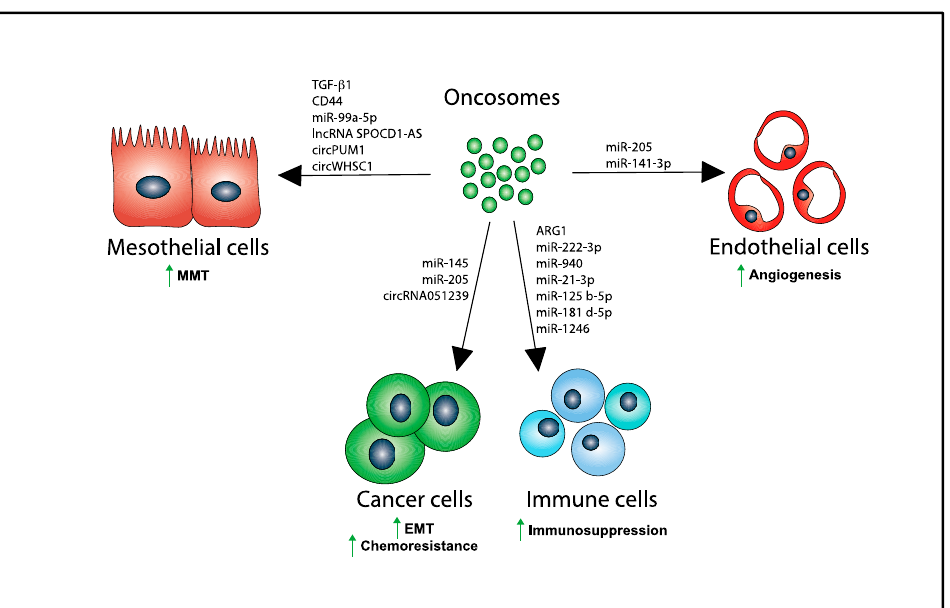
Figure 2. Several biomolecules are transferred via oncosomes from producing OvCA cells to their recipient target cells in the peritoneum inducing MMT in PMCs, EMT and chemoresistance in tumor cells, immunosuppression in immune cells, and angiogenesis in endothelial cells. Upward green arrows denote increase in the indicated biological process.